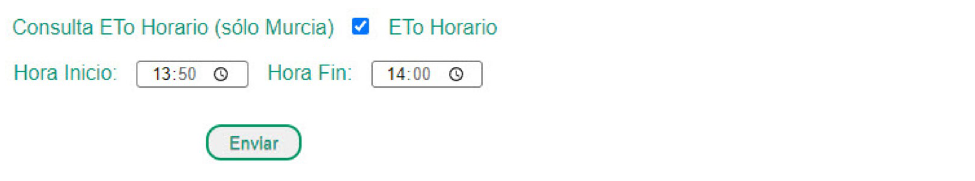
Figure 5. View of the hourly interval